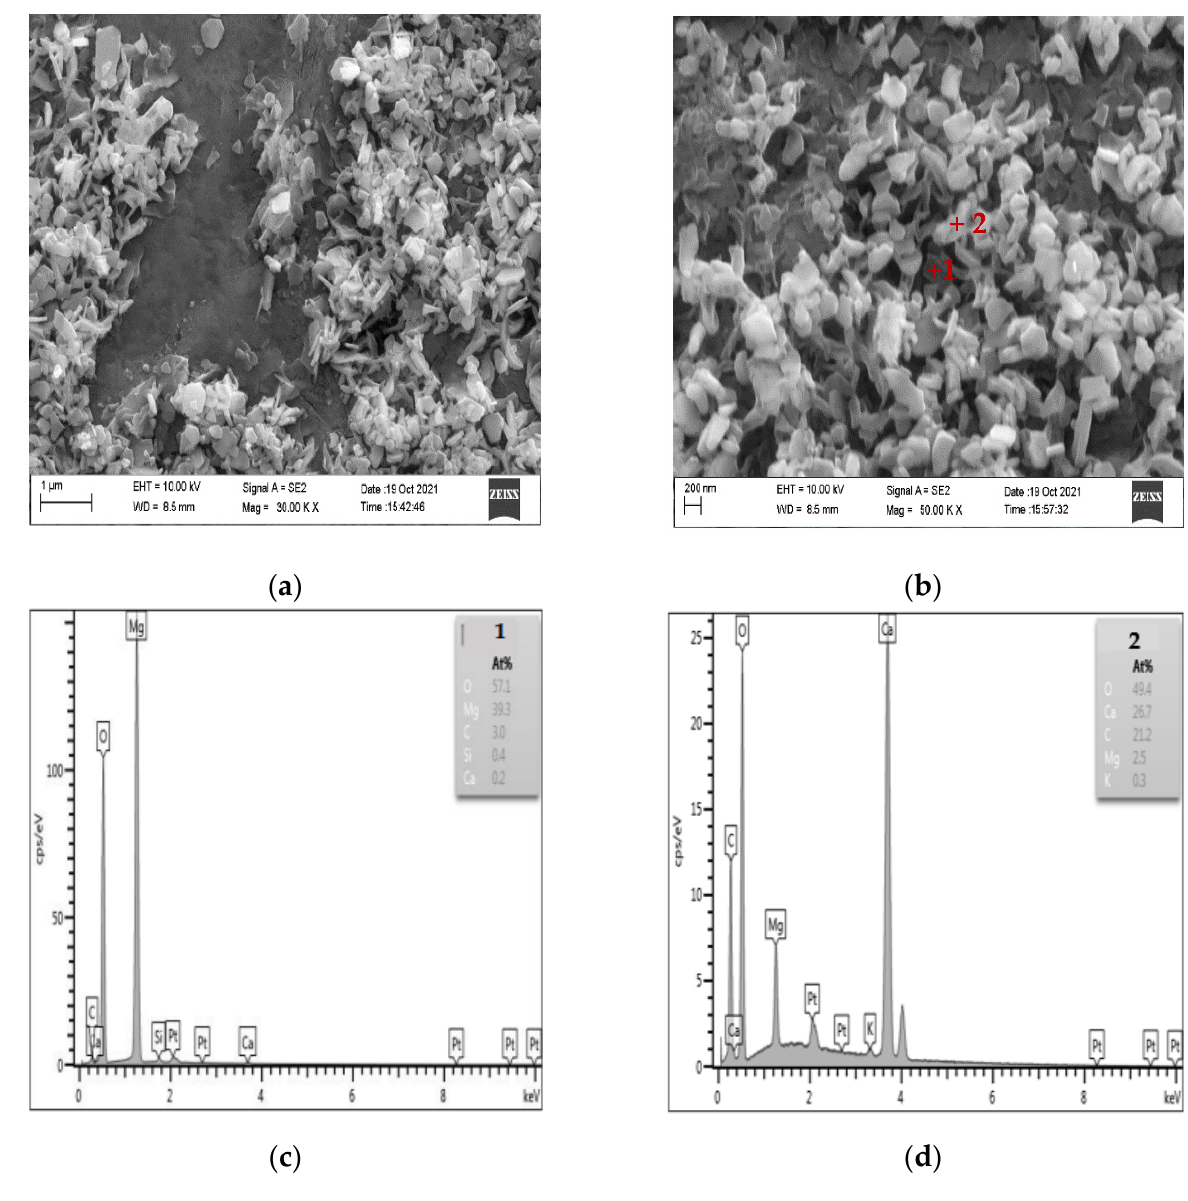
Figure 10. SEM-EDS images of dedolomitization reaction products. ( a , b ) The secondary electron image of dedolomitization reaction product ( c ) The elements composition of point 1 ( d ) The elements composition of point 2.